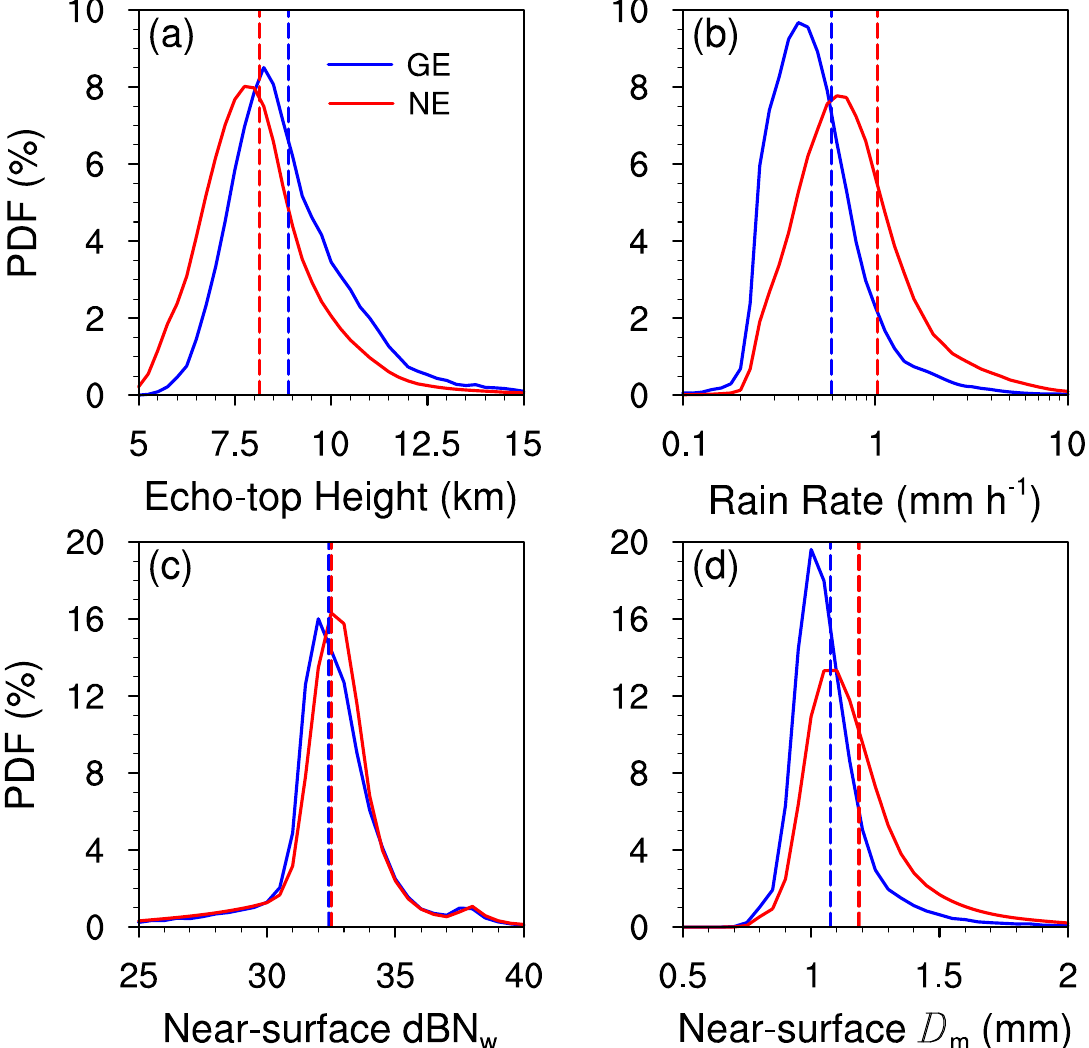
Fig. 3 Probability distribution function (PDF) of precipitation parameters for ghost echoes (GE) and normal echoes (NE). a Echo-top height. b Near-surface rain rate. c Near-surface droplet density (dBN w ). d Near-surface effective droplet diameter ( D m ). The dashed lines indicate the mean